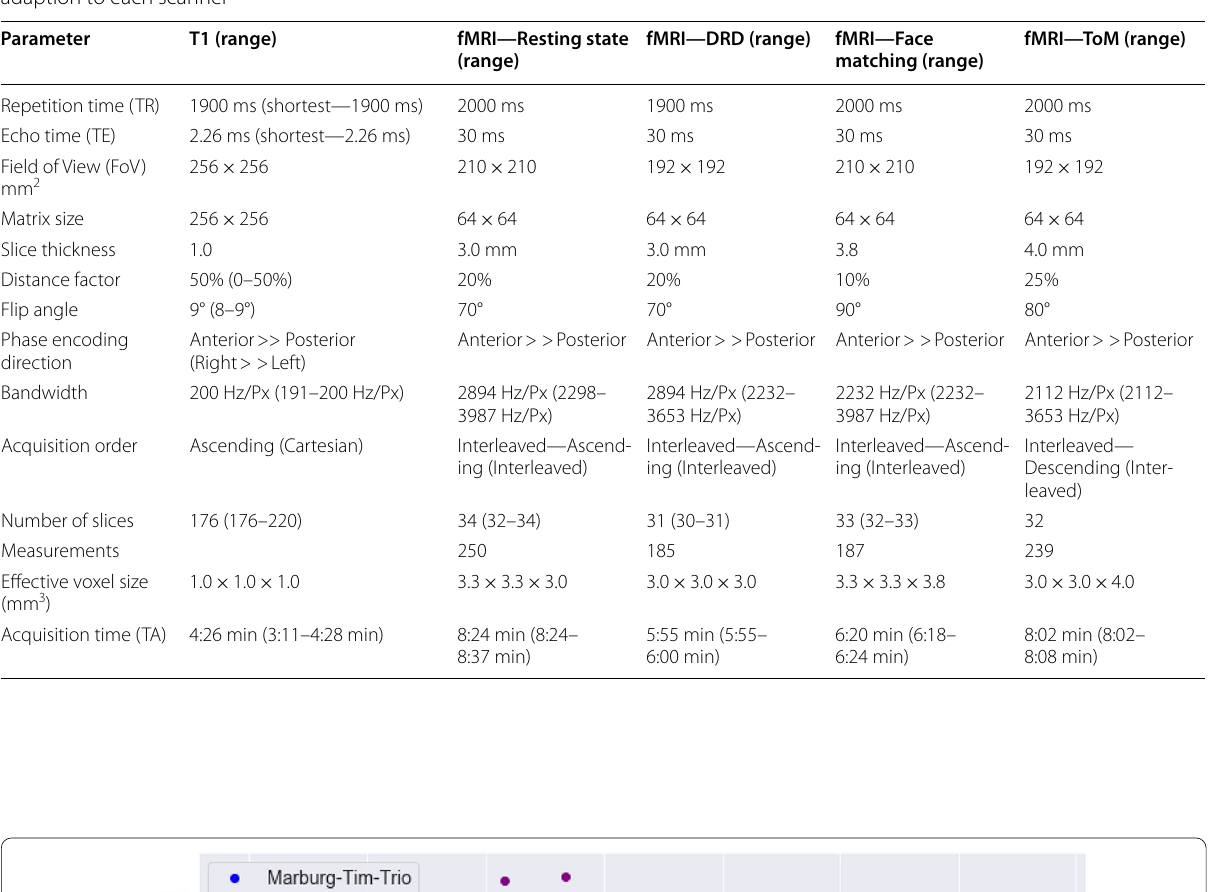
Table 6 The structural and functional MR parameters of the original MR sequence including the ranges of the parameters after the adaption to each scanner